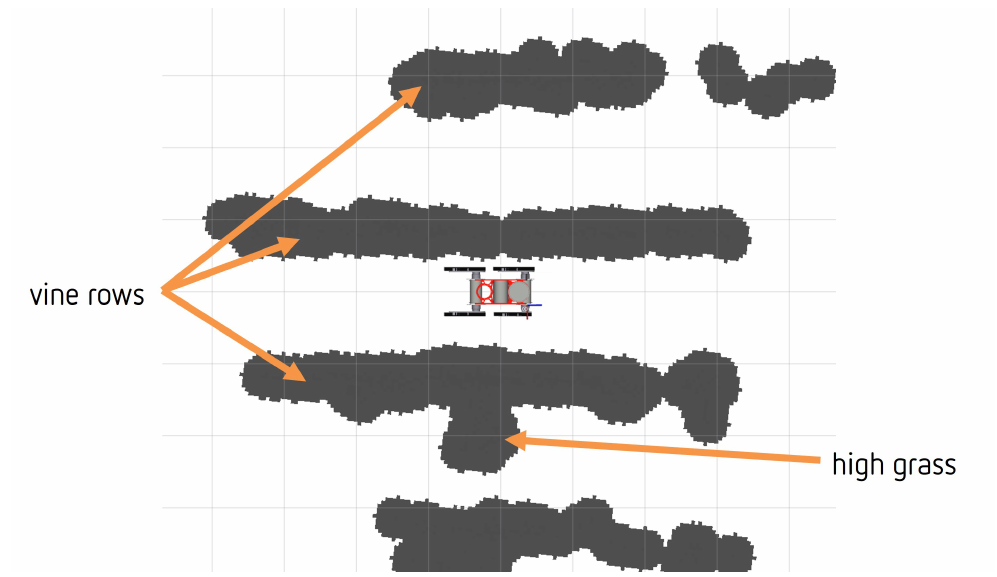
Figure 17. The 2D costmap generated from the 3D point cloud, used for the move_base